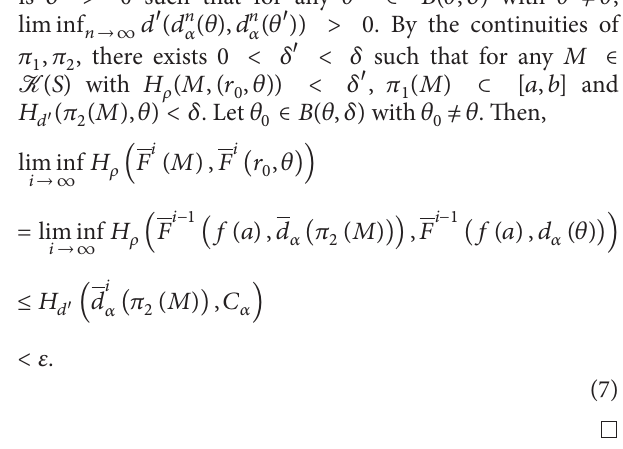
and 𝑓| [2/3,1] 𝑖 are linear, 𝑖